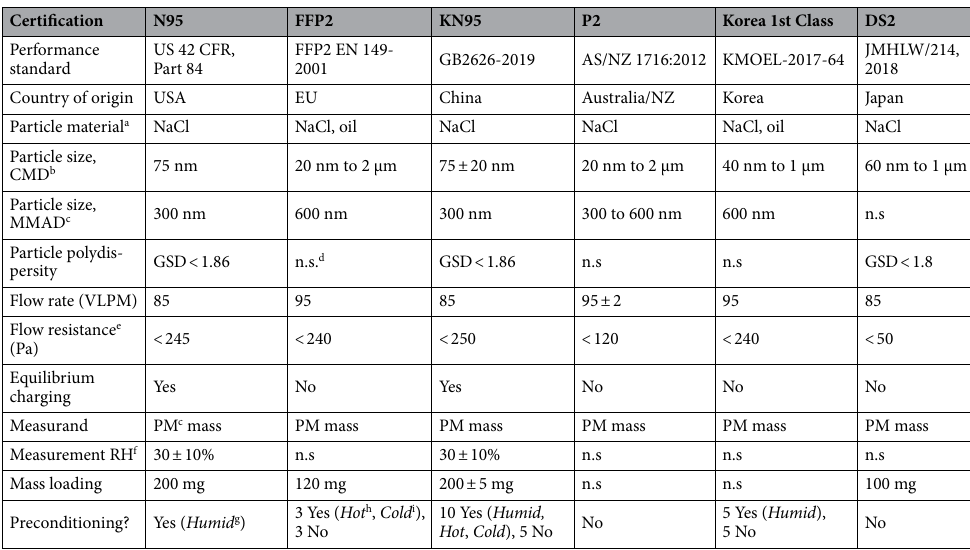
Table 3. Comparison of the NIOSH test method with similar international test methods. Flow resistance parameters have been simplified to maximum flow resistance, see text. PM particulate matter. a In all methods the oil used is paraffin oil. b Count median mobility diameter. c Mass median aerodynamic diameter. d n.s.: not specified. e Maximum resistance to inhalation or exhalation, whichever is smaller; corresponding flow